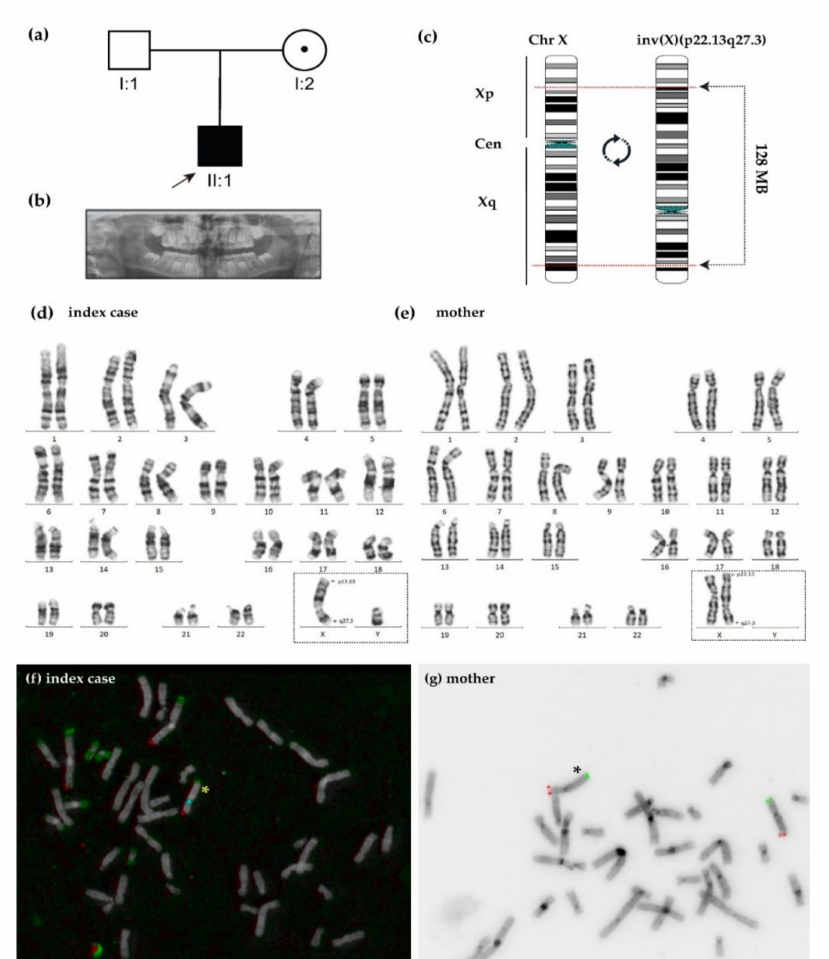
Figure 1. ( a ) Familiar pedigree of the index case with syndromic bilateral cataracts including dental anomalies and supernumerary teeth in orthopantomography ( b ). Black boxes denote affected male boy, dotted circle, carrier healthy mother, clear boxes, unaffected father. ( c – g ) Karyotyping and FISH analysis revealed a large and balanced pericentric inversion X(p22q27) in the index case ( d , f ) and his mother ( e , g ). Xp/Yp, Xq/Yq, and CEP X probe (locus DxZ1) are shown in green, red, and blue, respectively. Yellow or black asterisks show the X-inverted